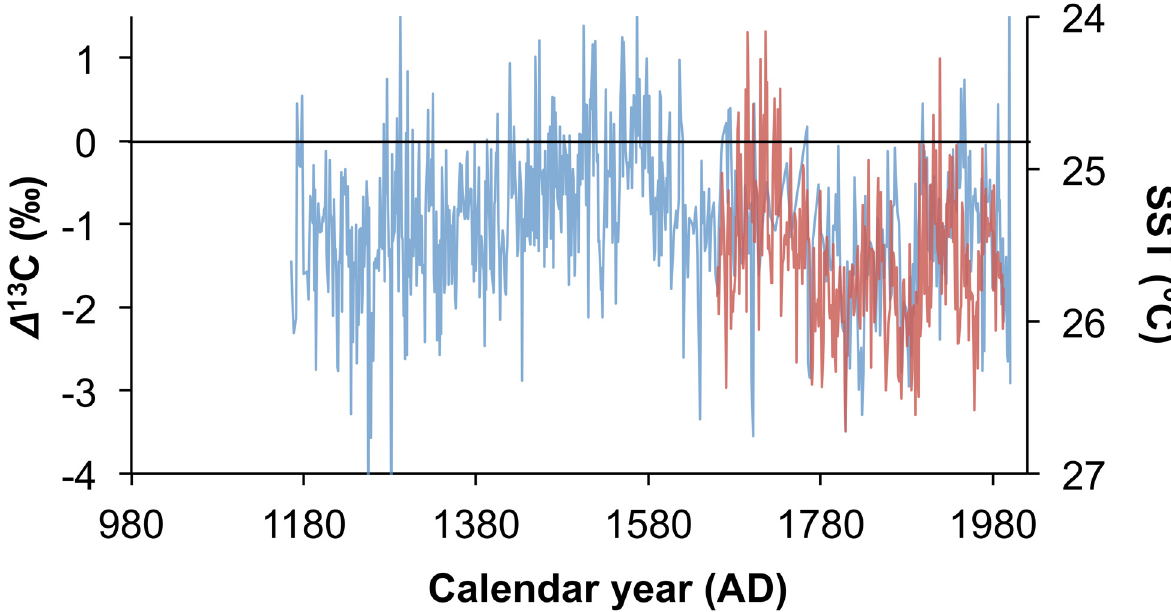
Fig 6. Residuals between the Mapungubwe and Pafuri δ 13 C records. The generally negative residual between the Mapungubwe record and the Pafuri record is caused by a lower rainfall in the Mapungubwe region (blue, left axis). This correlates significantly with the sea surface temperatures in the Agulhas Current Core region [32, 33] (red, right axis), suggesting that the residual is forced by the east/ west location of the temperate tropical trough rainfall